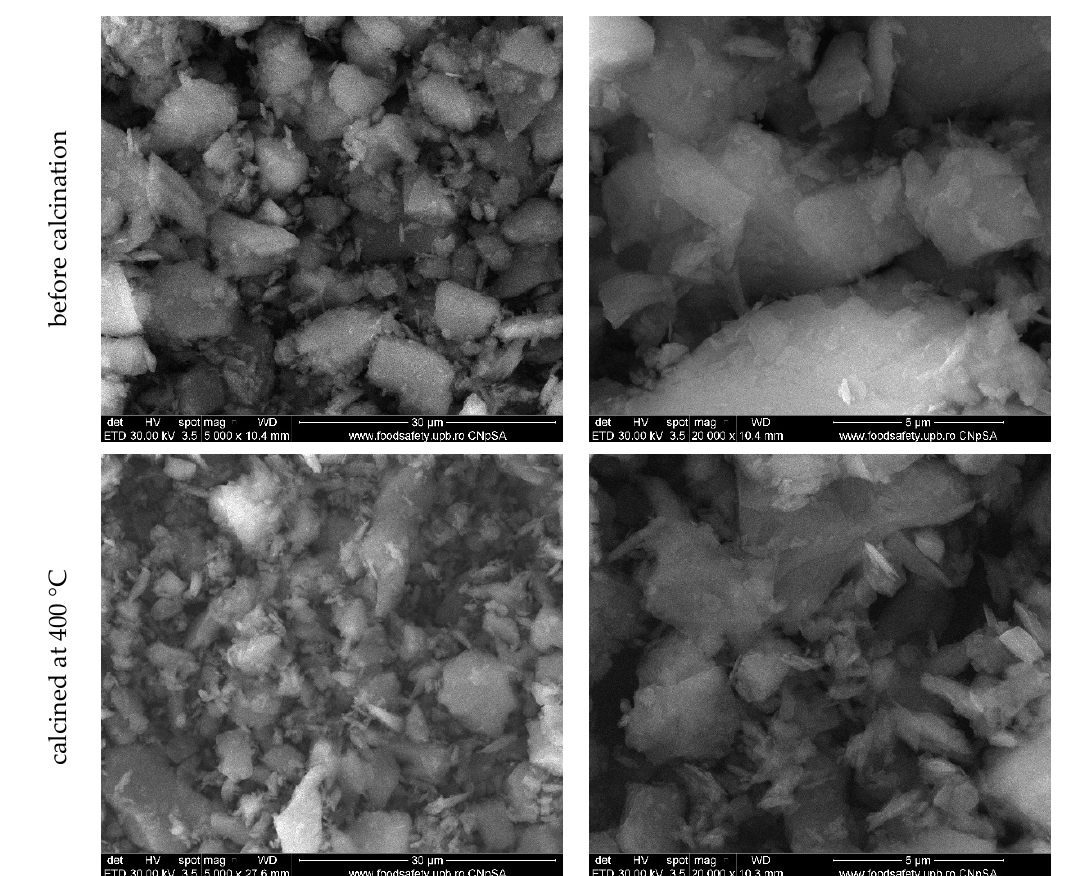
Figure 3. SEM images of the GDAH-02 powder before the thermal treatment and after calcination at 400 °C.